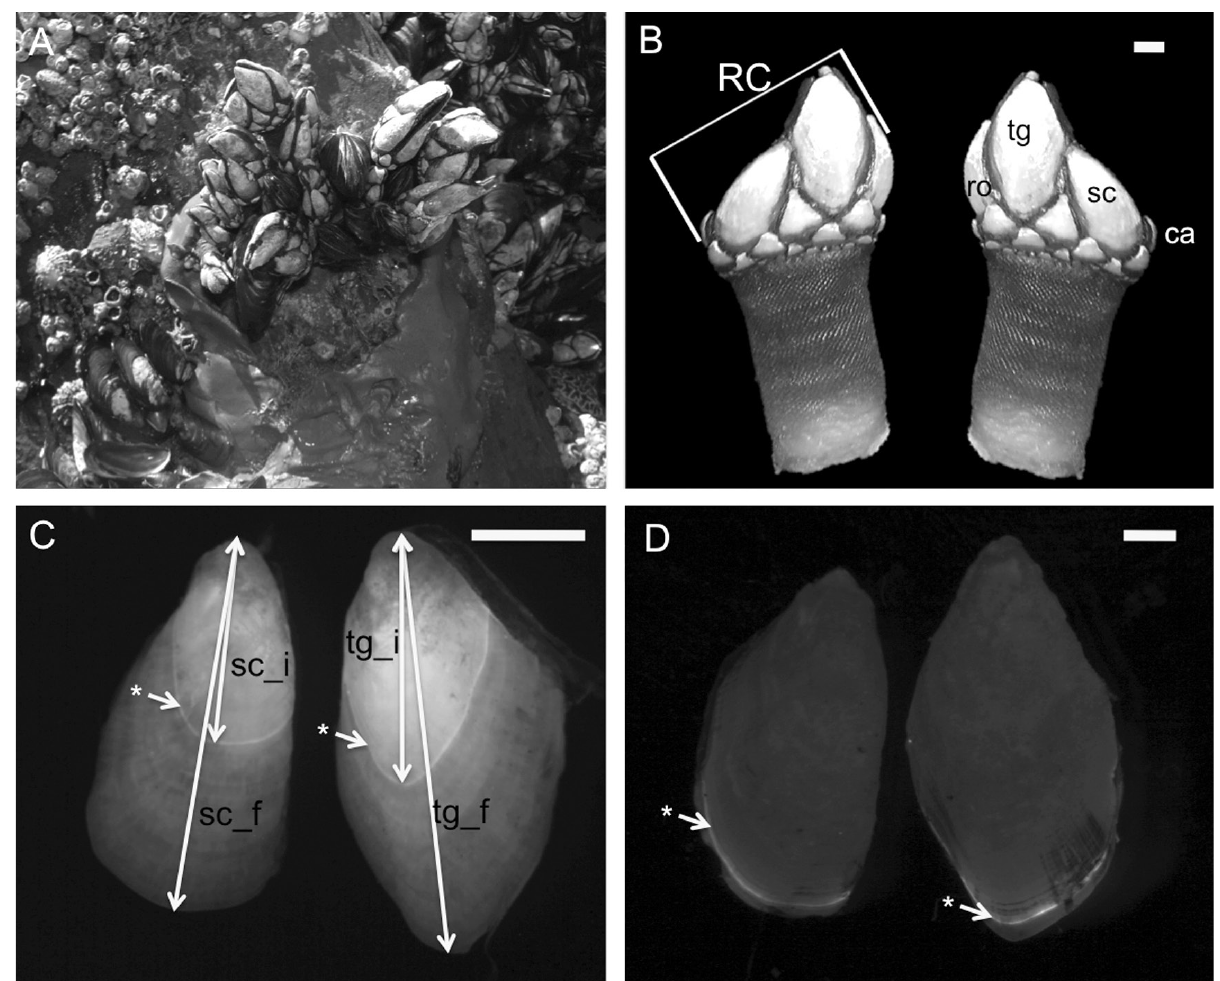
Fig. 1. – A, a clump of calcein marked barnacles fixed to the rocky substrate with marine epoxy; B, P. pollicipes lateral view, identifying capitular plate position (sc, scutum; tg, tergum; ro, rostrum; ca, carina) and measured variable (RC, maximum rostro-carinal length); C, left side scutum and tergum plates from a marked juvenile barnacle (* indicates the edge of the calcein mark in the initial capitular plates), arrows show measured variables (sc_i, initial scutum length: sc_f, final scutum length; tg_i, initial tergum length; tg_f, final tergum length) for each capitular plate; D, left side scutum and tergum plates from a marked adult P. pollicipes showing the calcein marks visible only at the edge of the initial capitular plate area (*). 1-mm scale bars are shown in images B, C and